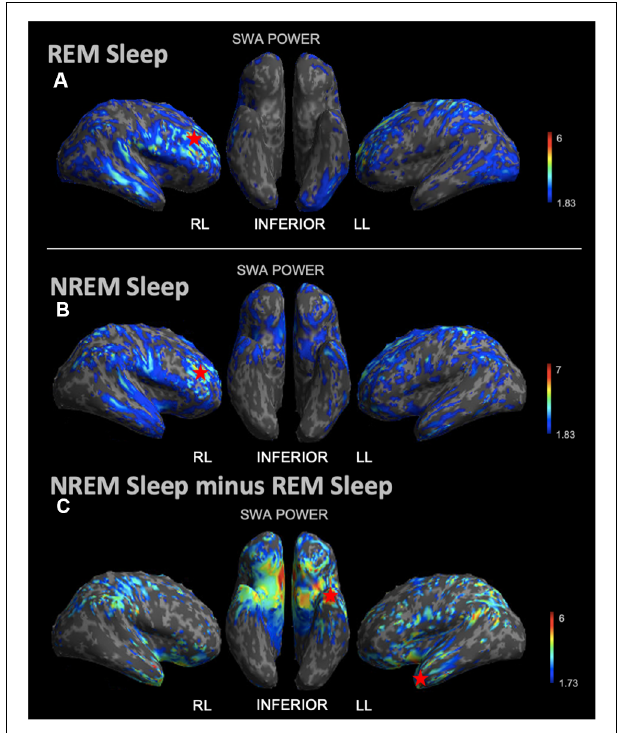
FIGURE 3 | Source space reconstruction of SWA power for the patient vs. controls during NREM sleep and REM sleep taken in isolation, and for NREM sleep subtracted by REM sleep. Red stars denote SWA maximums. We observed NREM sleep and REM sleep SWA maxima within the right frontal lobe. SWA maxima localized to the left temporal lobe when intrasubject NREM sleep SWA was subtracted by REM sleep SWA before statistical analysis. (A) Patient REM sleep SWA power subtracted by controls REM sleep SWA power; the red star shows the SWA maximum. (B) Patient SWA power subtracted by controls SWA power during NREM sleep; the red star shows the SWA maximum. (C) Patient vs. controls comparison for NREM sleep SWA power subtracted by REM sleep SWA power; the red star shows the SWA maximum. Each T map pictured above is thresholded for a display of uncorrected p < 0.05. The jet color scale indicates t -values. Abbreviations: RL = right lateral; LL = left lateral. Sleep